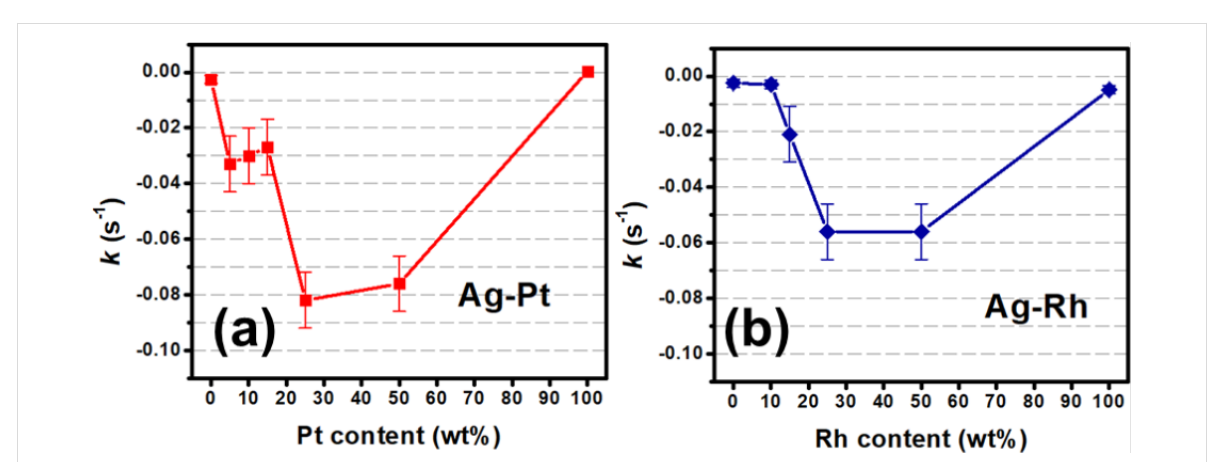
Figure 5: Rate constants for the (a) Ag–Pt and (b) Ag–Rh systems at a variety of loading ratios. Catalytic enhancement is observed at Pt contents as low as 5% for the Ag–Pt system and Rh contents as low as 15% for the Ag–Rh system. The rate constant k is normalized for the diminishing concen- tration of 4-nitrophenolate over the cycling experiment. Errors bars represent the standard deviation of six separate determinations of k for 1:1